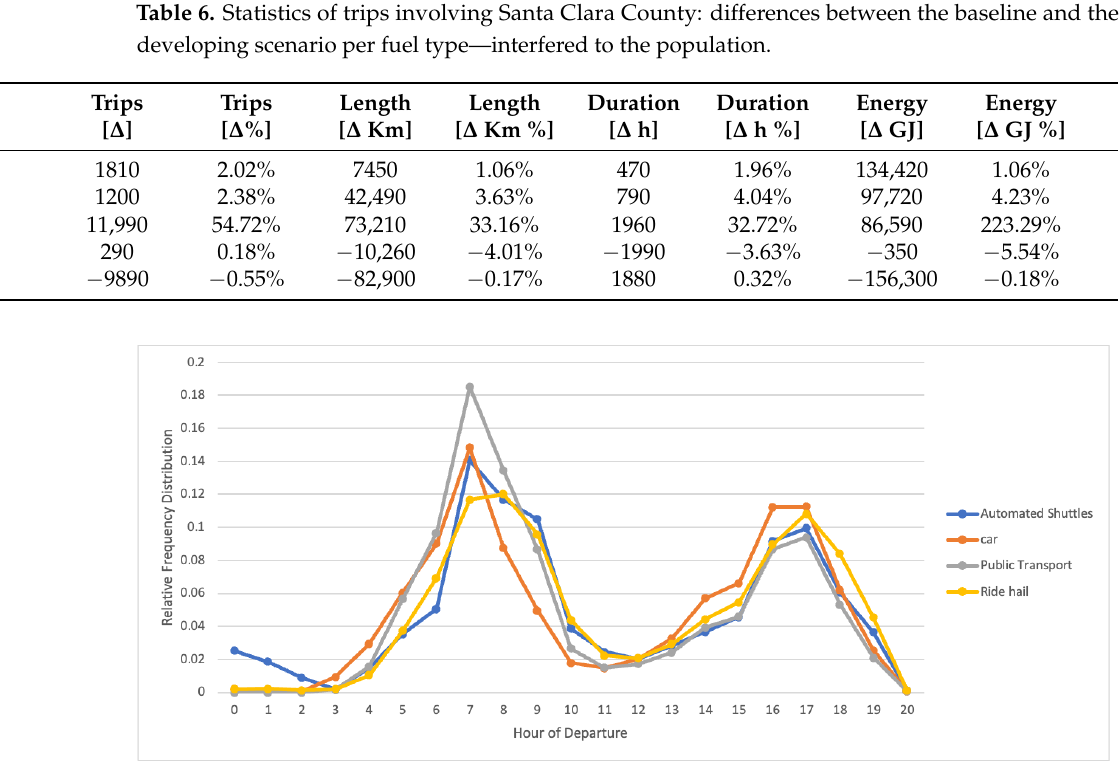
Figure 4. Relative frequency distribution of departure time of automated shuttles during the day, compared with the usage of cars, other ride-hails, and public transport